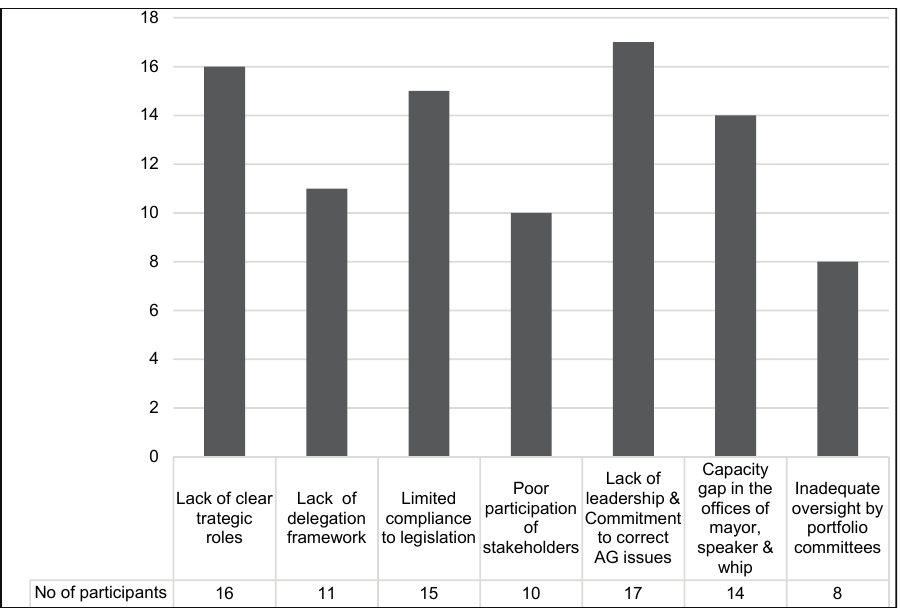
Figure 1: Response on the role of political office-bearers for oversight and accountability as a measure for transparency and